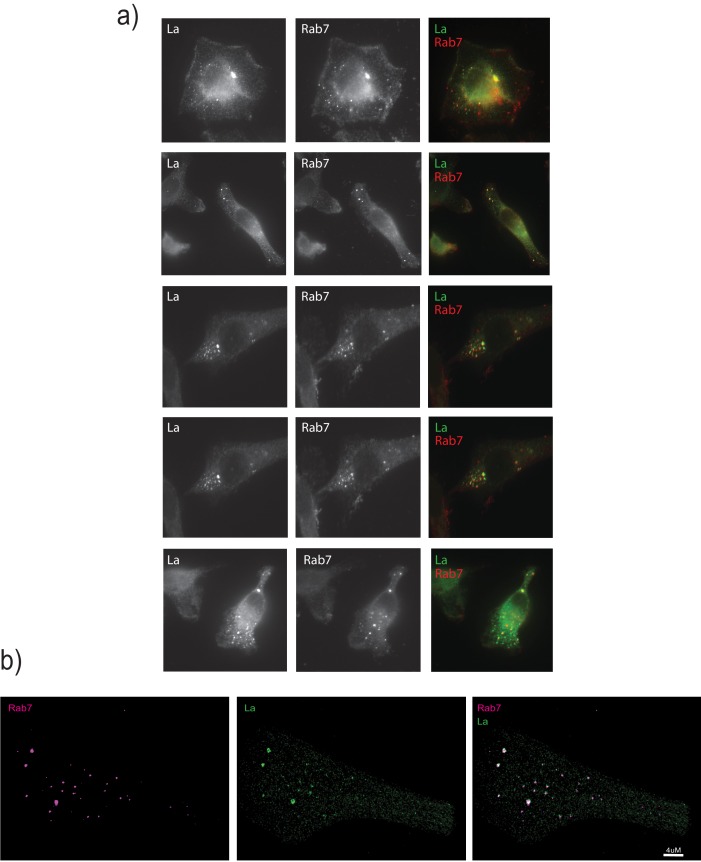
La associates with Rab7-positive vesicles.(a) Immunofluorescence for endogenous La and Rab7 was performed. WT cells were fixed and permeabilized with 0.02% saponin in order to preserve the nuclear envelope intact and avoid detection of nuclear La. (b) Structured illumination microscopy (SIM) was used to achieve higher resolution.